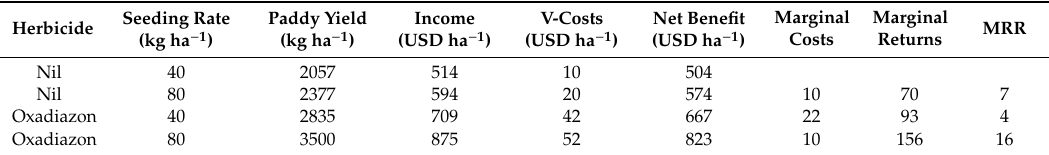
Table 9. Marginal rates of return (MRR) for increasing seeding rates vs. herbicide for weed suppression in